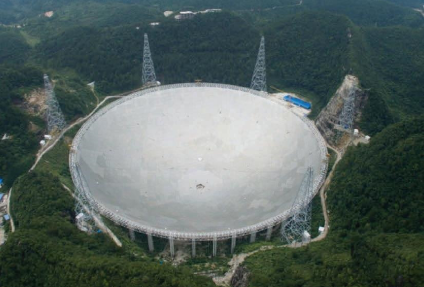
Figure 8: FAST (https://www.sohu.com/a/115089151_116413).